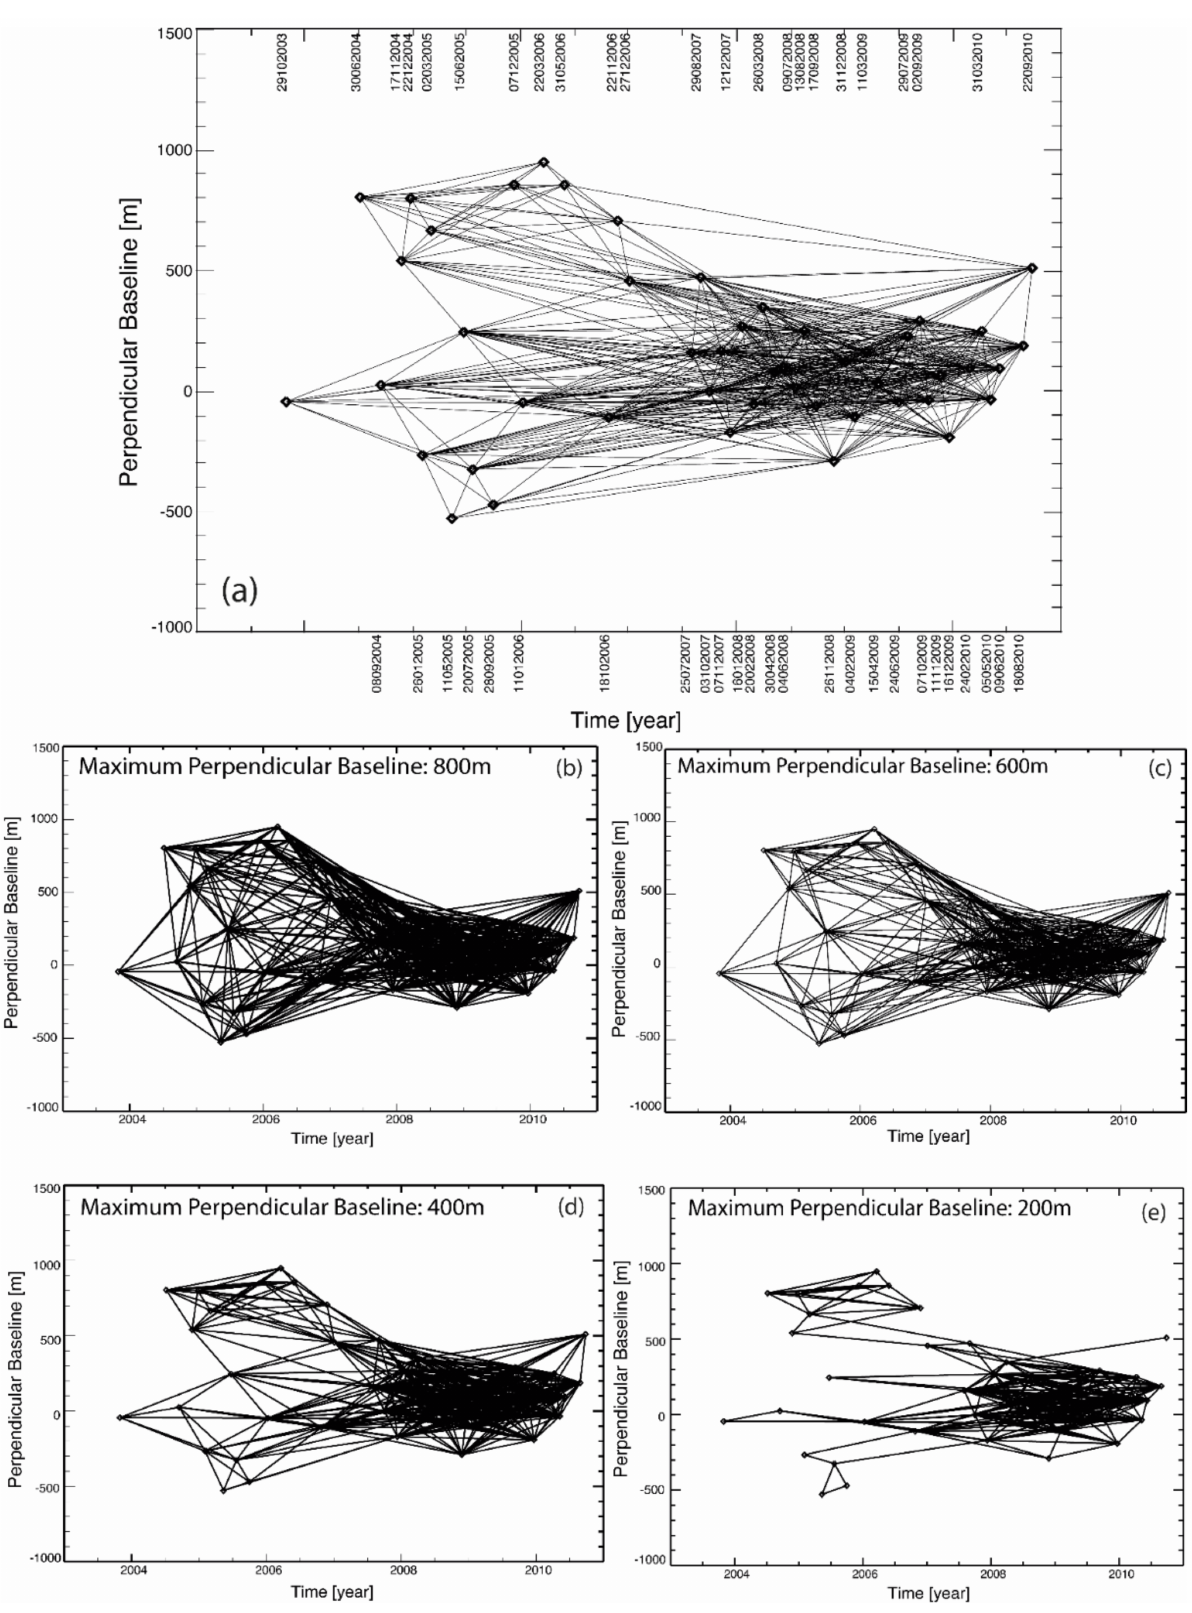
Figure 9. Sets of SB interferograms relevant to South California’s area obtained by processing a group of ENVISAT/ASAR images. The SB InSAR data pairs are identified by imposing a constraint on the maximum perpendicular baseline of ( a ) 1100 m, ( b ) 800 m, ( c ) 600 m, ( d ) 400 m, and ( e ) 200 m. Dates shown in this Figure are expressed with the format (day, month,